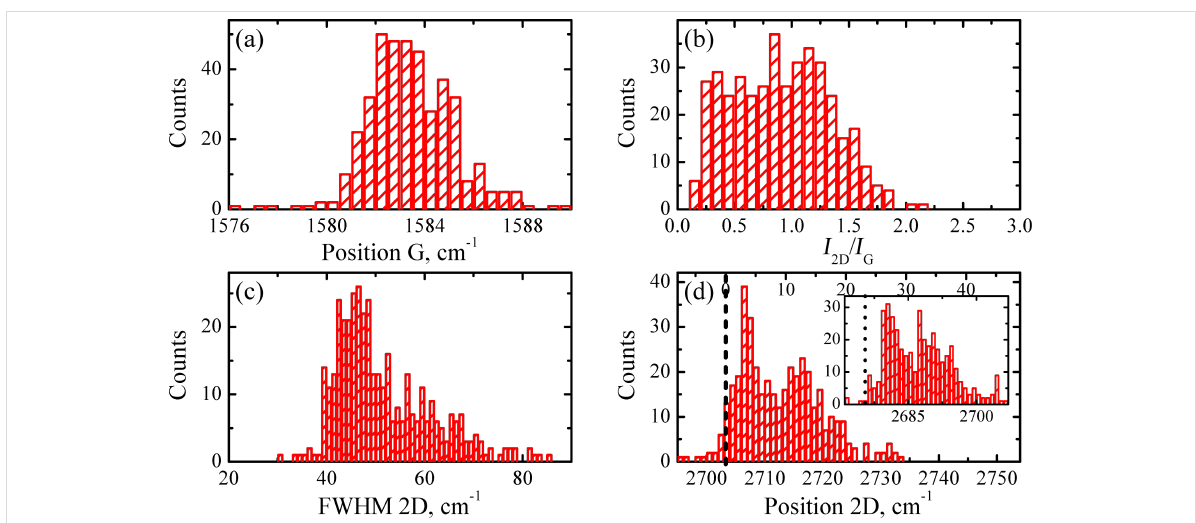
Figure 6: Raman mapping histograms for sample B on a SiO 2 /Si substrate as obtained from Raman maps of Figure 4. (a) G band position. (b) I 2D / I G . (c) FWHM of the 2D band. (d) 2D band position. Inset: 2D band as measured for the laser excitation wavelength of 532 nm. The vertical dashed lines on panel (d) show the position of the 2D band of SLG on SiO 2 according to